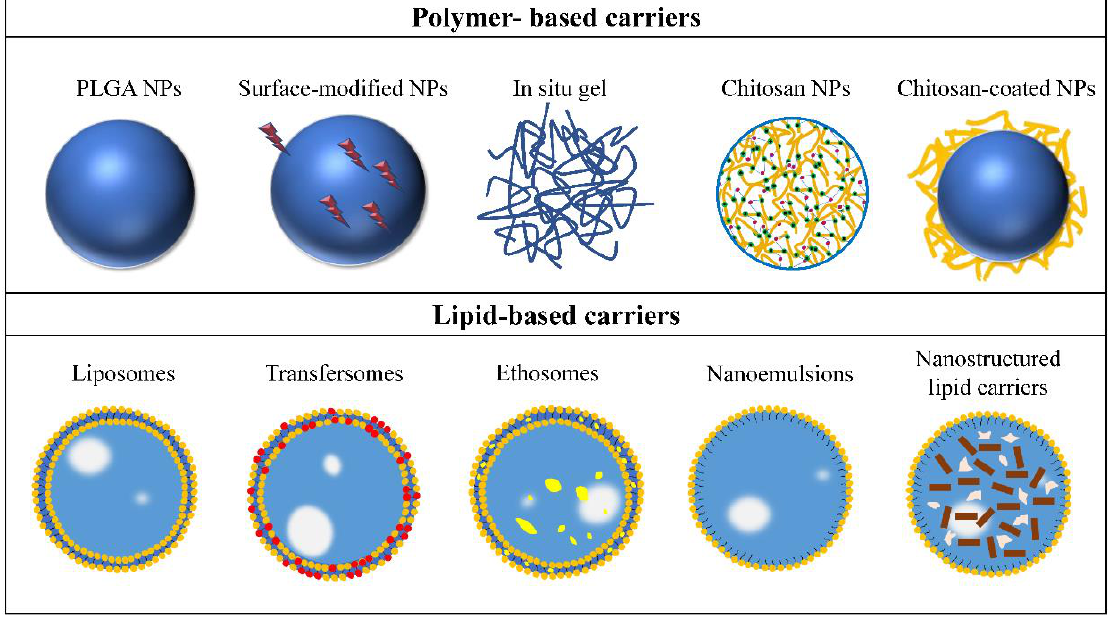
Figure 3. Carriers for intranasal administration of antidepressant active ingredients. Adapted with permission from Ref. [24]. Copyright 2018, Elsevier.